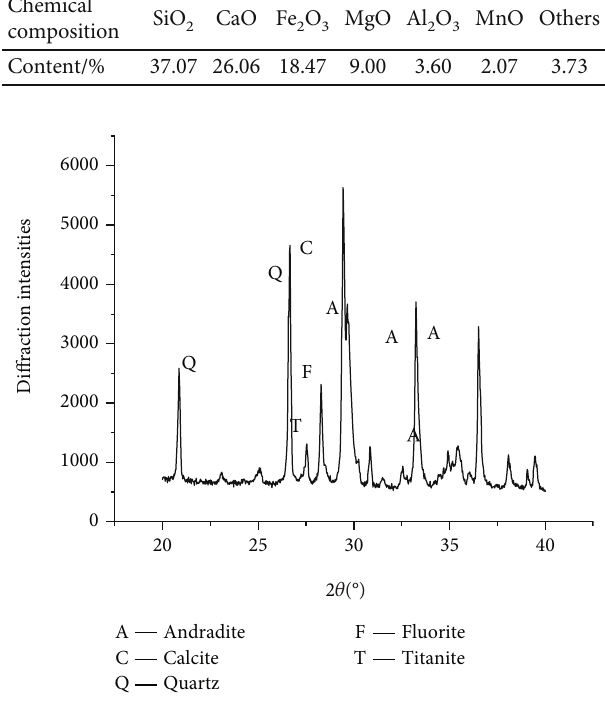
Figure 1: XRD spectrum of tailing